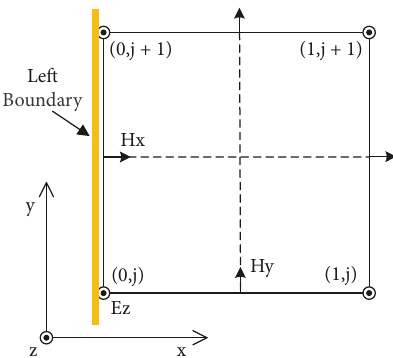
Figure2:Thearrangementoffieldcomponentsatthelefttruncating